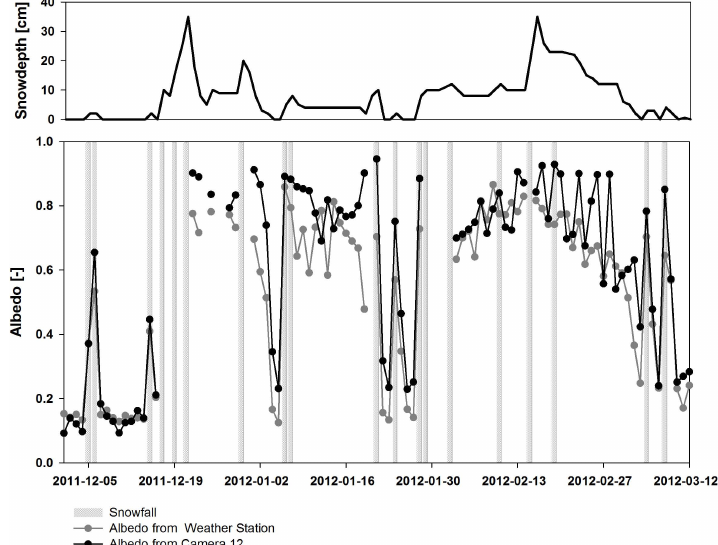
Fig. 12. Comparison of albedo values derived from the image analysis and measured albedo values at the weather station for the winter season 2011/2012 with snowfall events. Snow depth dynamic at this location is shown in the graph above. From the 103 day period, 86 days could be used for analysis.